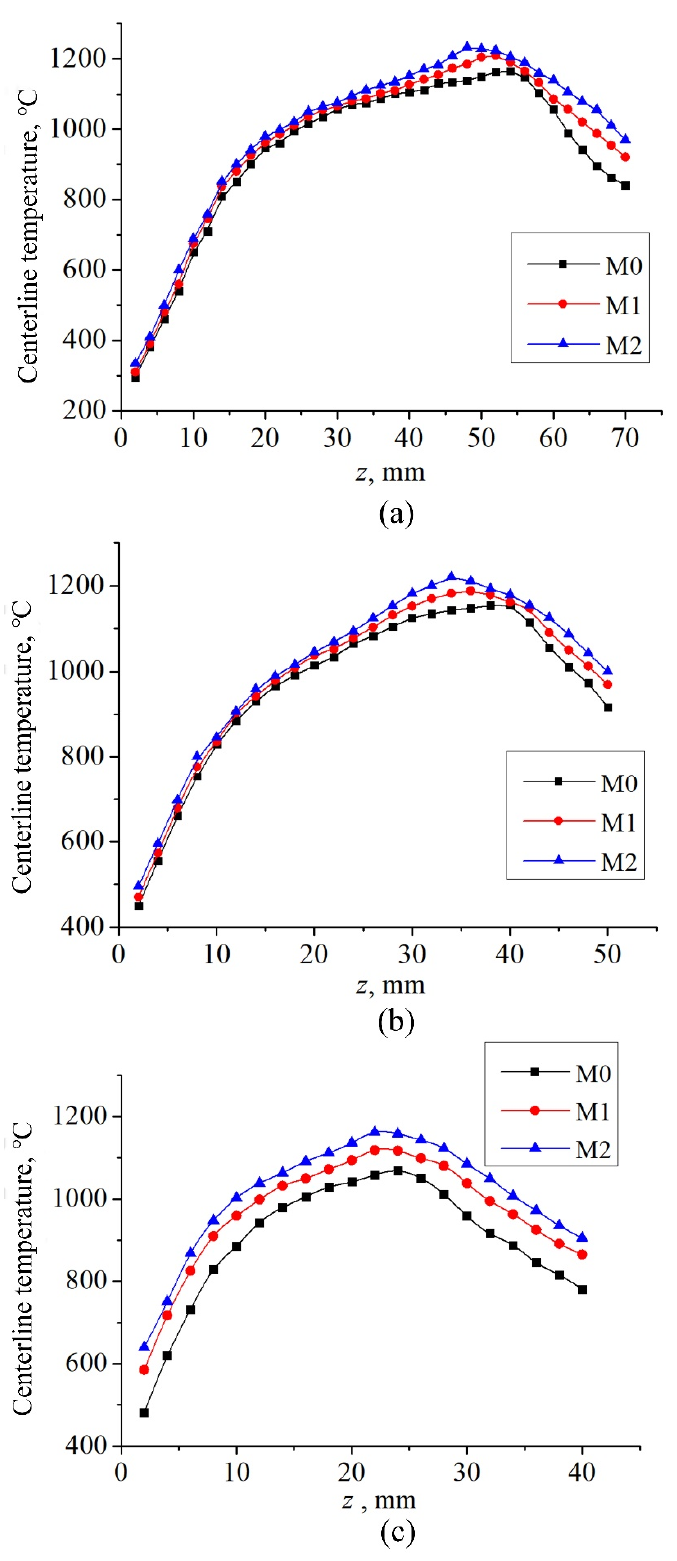
Figure 6. Centerline temperature distributions of diffusion flames: ( a ) Re = 84, ( b ) Re = 63, and ( c ) Re =